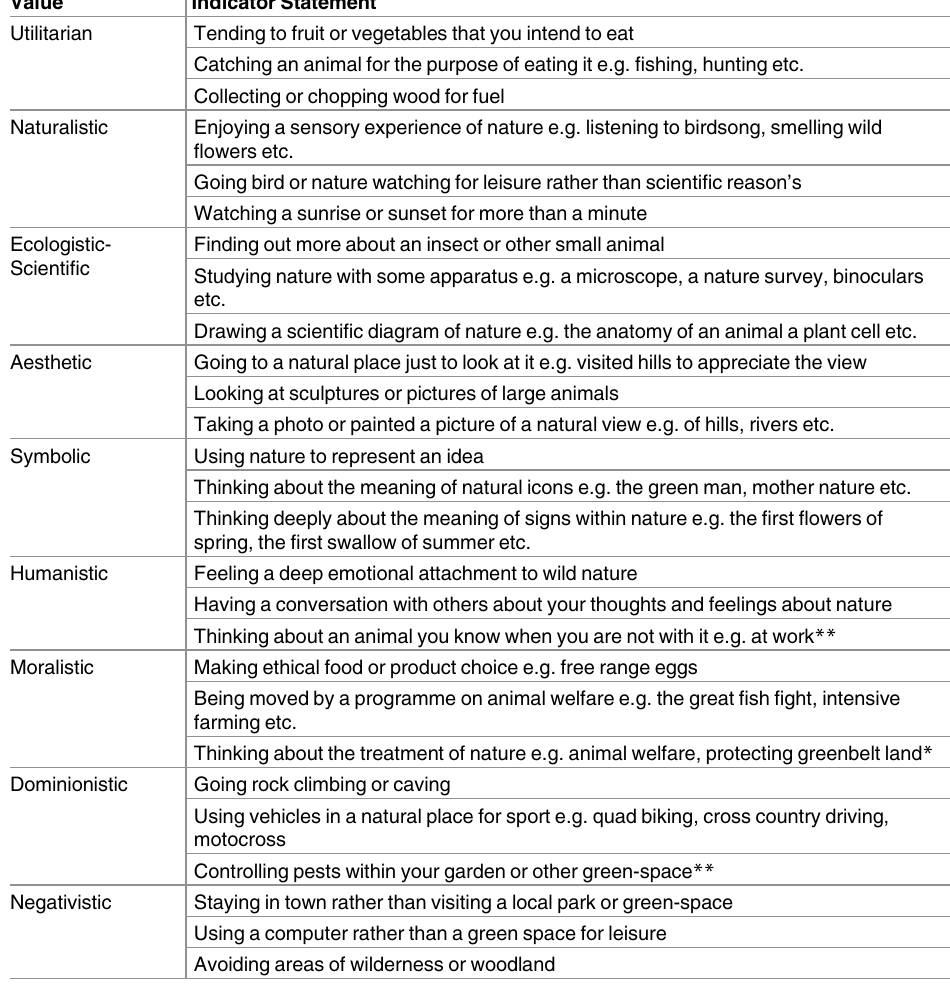
Table 2. Post validation engagement activities relating to the values of the Biophilia